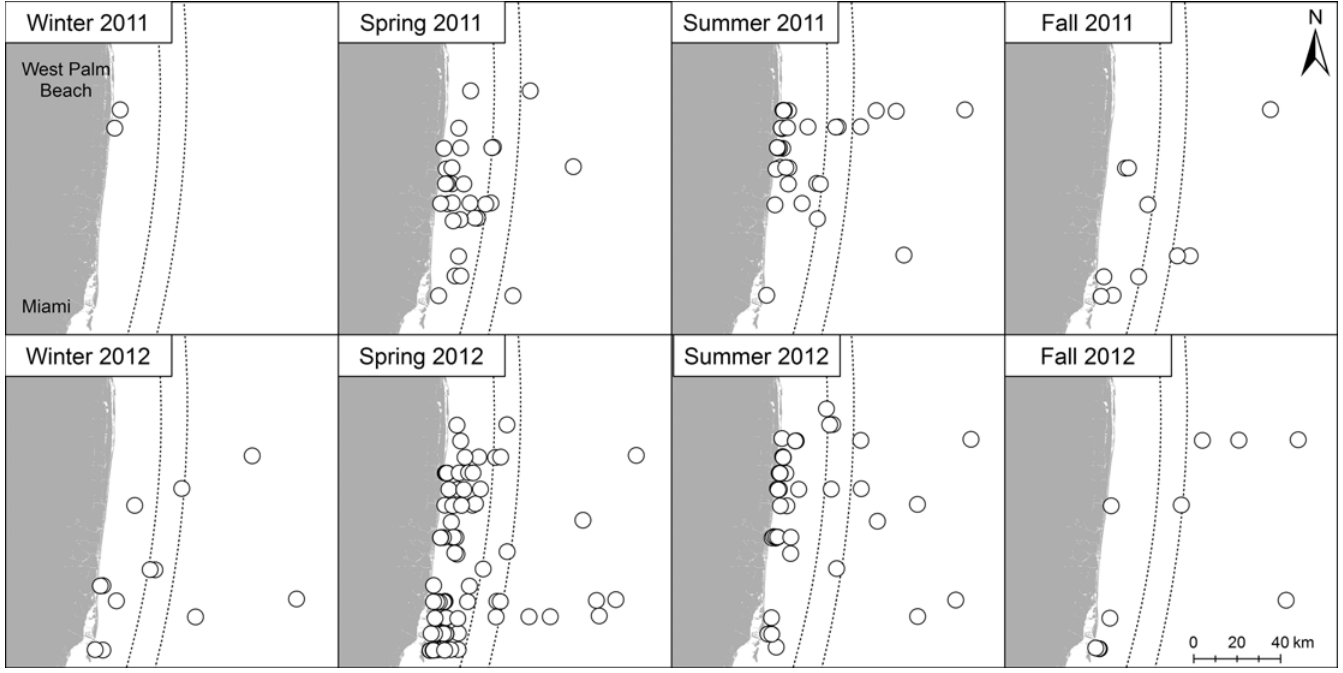
analyses. Due to low numbers of turtle observations in some seasons and low numbers of some species, observations were pooled across seasons and species to estimate the probability of detection. Despite rigorous MCDS analysis, results indicated that the best model did not include any of the proposed covariates. Model selection using Akaike ’ s Information Criterion (AIC) identified a hazard-rate model with no adjustments as the best fit for sea turtle detection in this study (Table 2; Fig 4). Estimates of sea turtle density were generally higher for spring (March-May) and summer (June-August) seasons than during fall (September-November) and winter (December-